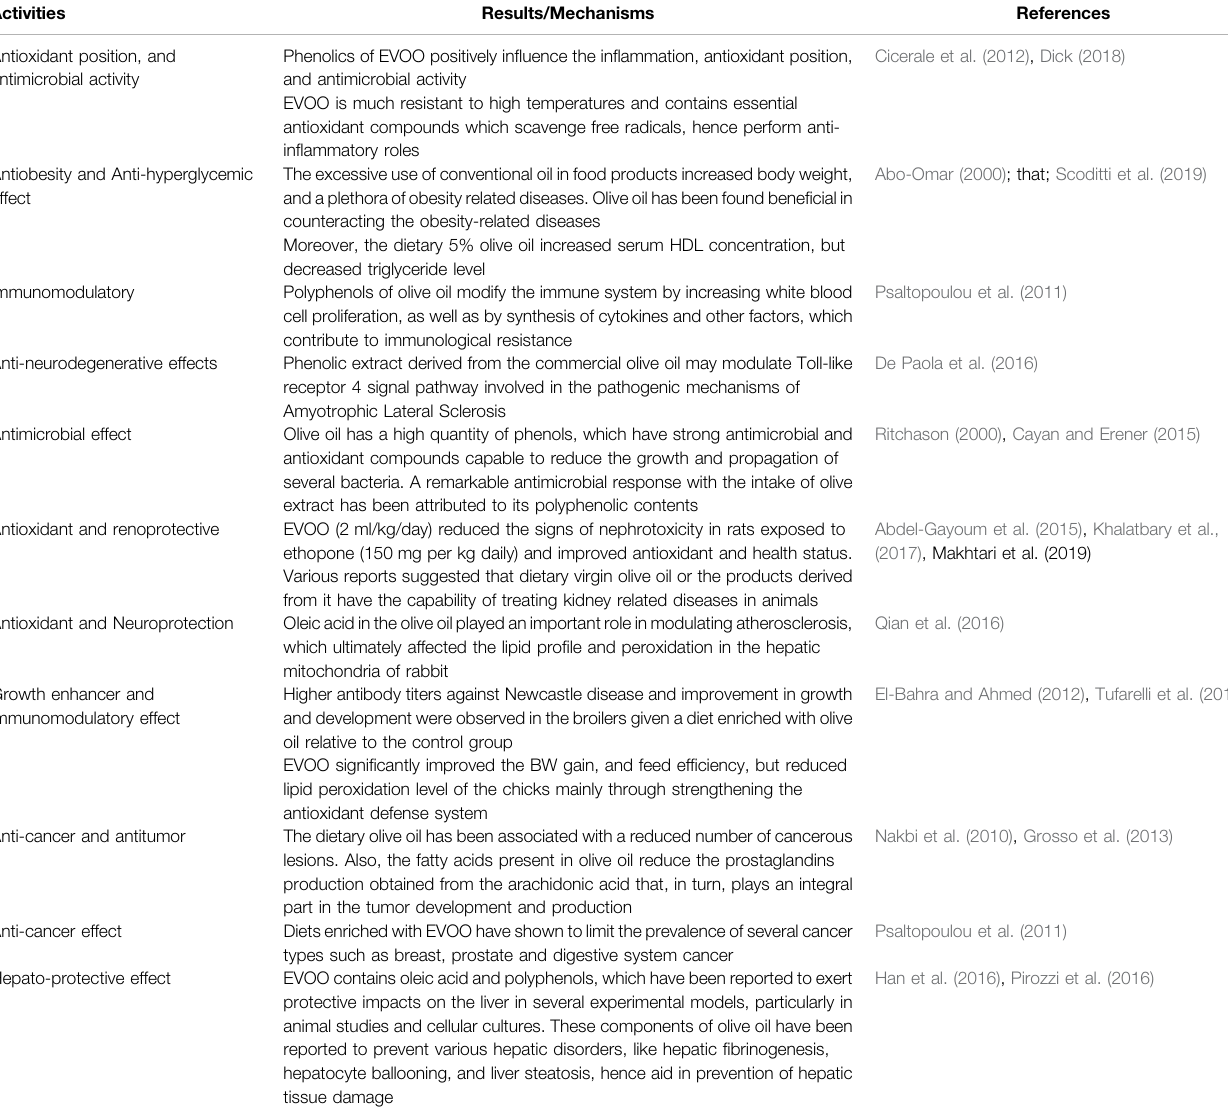
TABLE 1 | Biological effects and health bene fi ts of olive